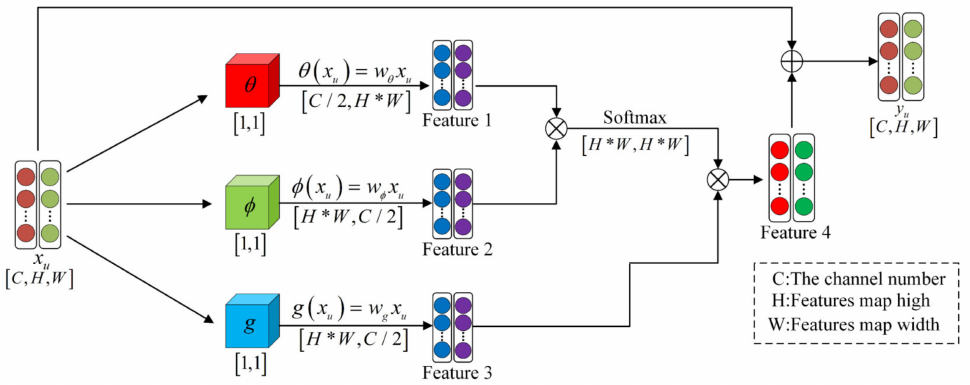
Figure 1. The flow chart of the non-local